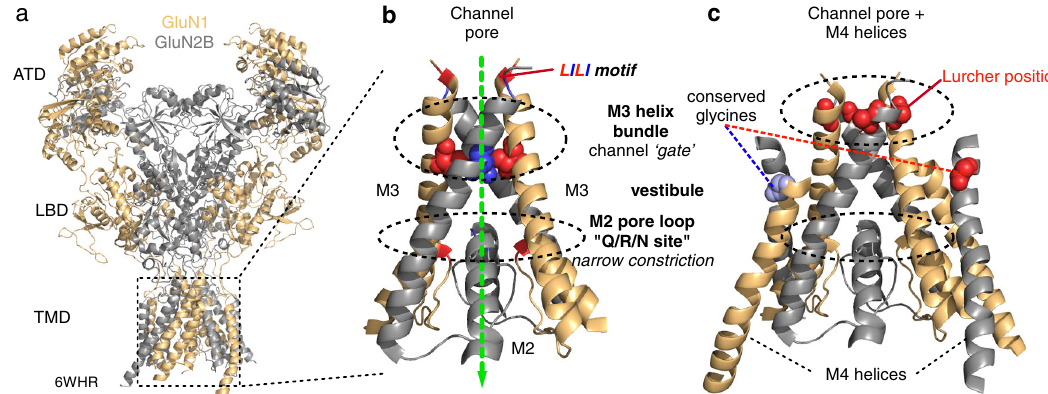
Fig. 1 | Architecture of the NMDA receptors and their ion channel. a NMDARs function as tetramers (2 GluN1/2 GluN2 subunits) with four domains in each sub- unit: extracellular amino-terminal (ATD) and ligand-binding (LBD) domains; transmembrane domain (TMD) forming the ion channel; and an intracellular C-terminal domain (not shown). GluN1/GluN2B, 6WHR 25 . b In homology to an inverted K + channels, the ion channel core is the pore domain: transmembrane helices M1 (=TM1 or S5) (not shown for clarity) and M3 (=TM2 or S6) and the M2